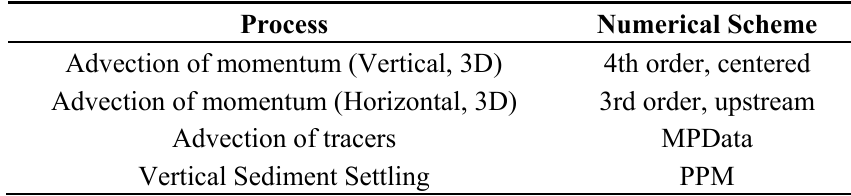
Table 2. Numerical Schemes for Waipaoa Shelf